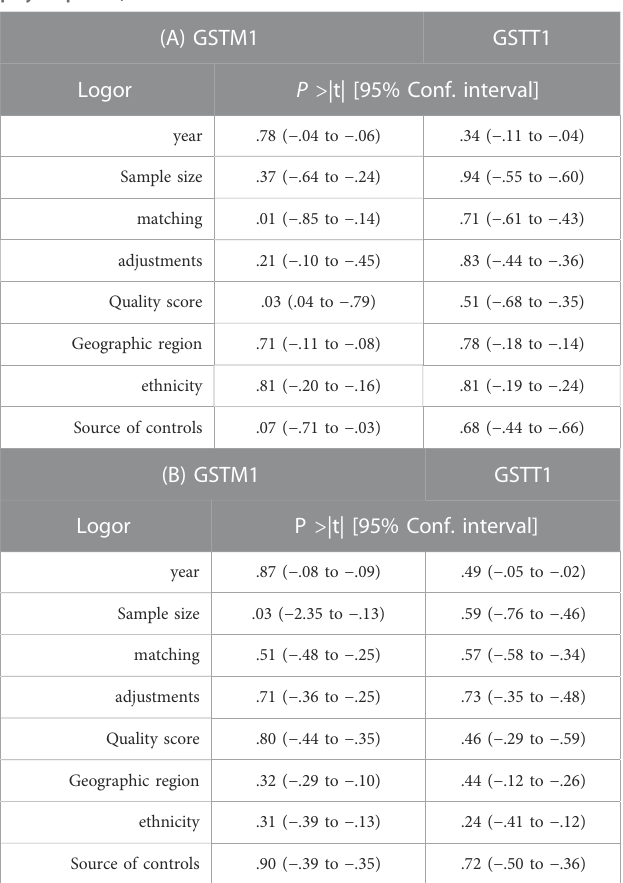
TABLE 8 A) Meta-regression analysis of GSTM1 , GSTT1 gene polymorphisms, and risk of cervical cancer. (B) Meta-regression analysis of GSTM1 , GSTT1 gene polymorphisms, and risk of ovarian